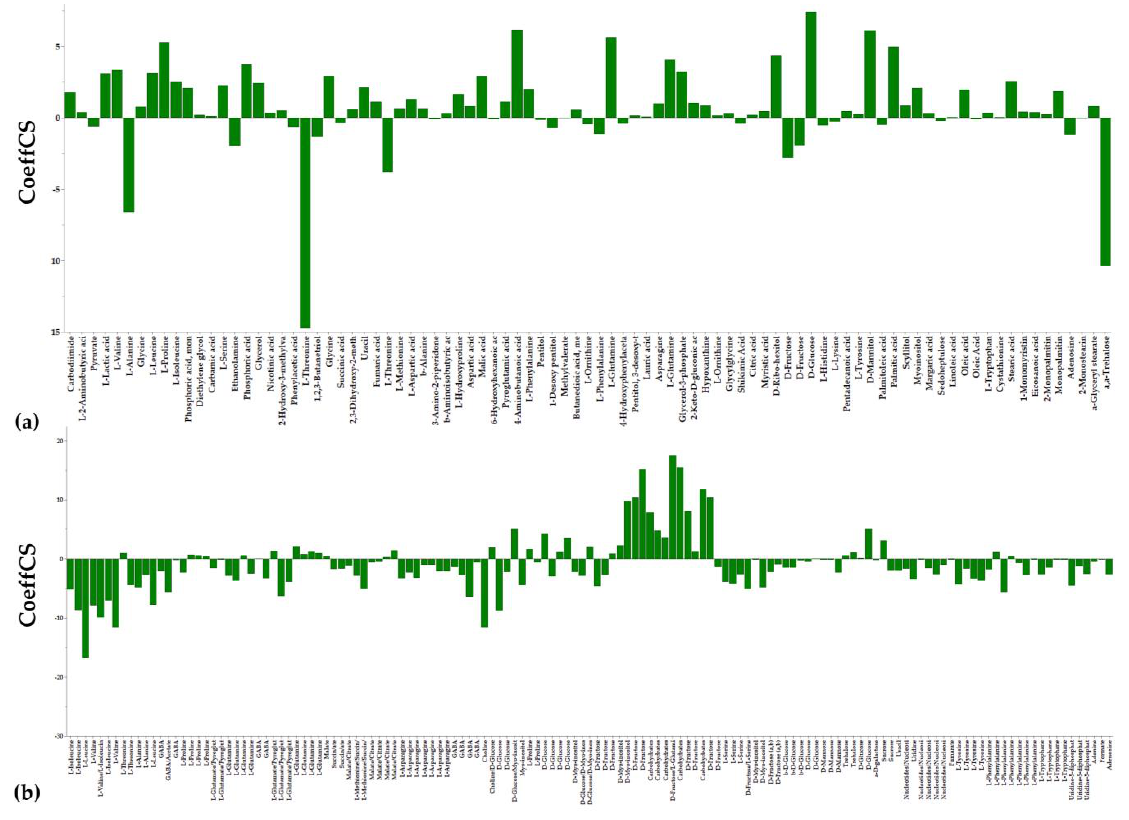
Figure 5. Coefficient plots displaying the metabolite differences between the untreated and lipopeptide-treated Colletotrichum acutatum cultures using scaled and centered PLS regression coefficients (CoeffCS) performing ( a ) GC/EI/MS and ( b ) 1 H NMR metabolomics analysis. Positive CoeffCS values correspond to metabolites with increased levels in the untreated, whereas negative to those with increased levels in the lipopeptide-treated fungal cultures.